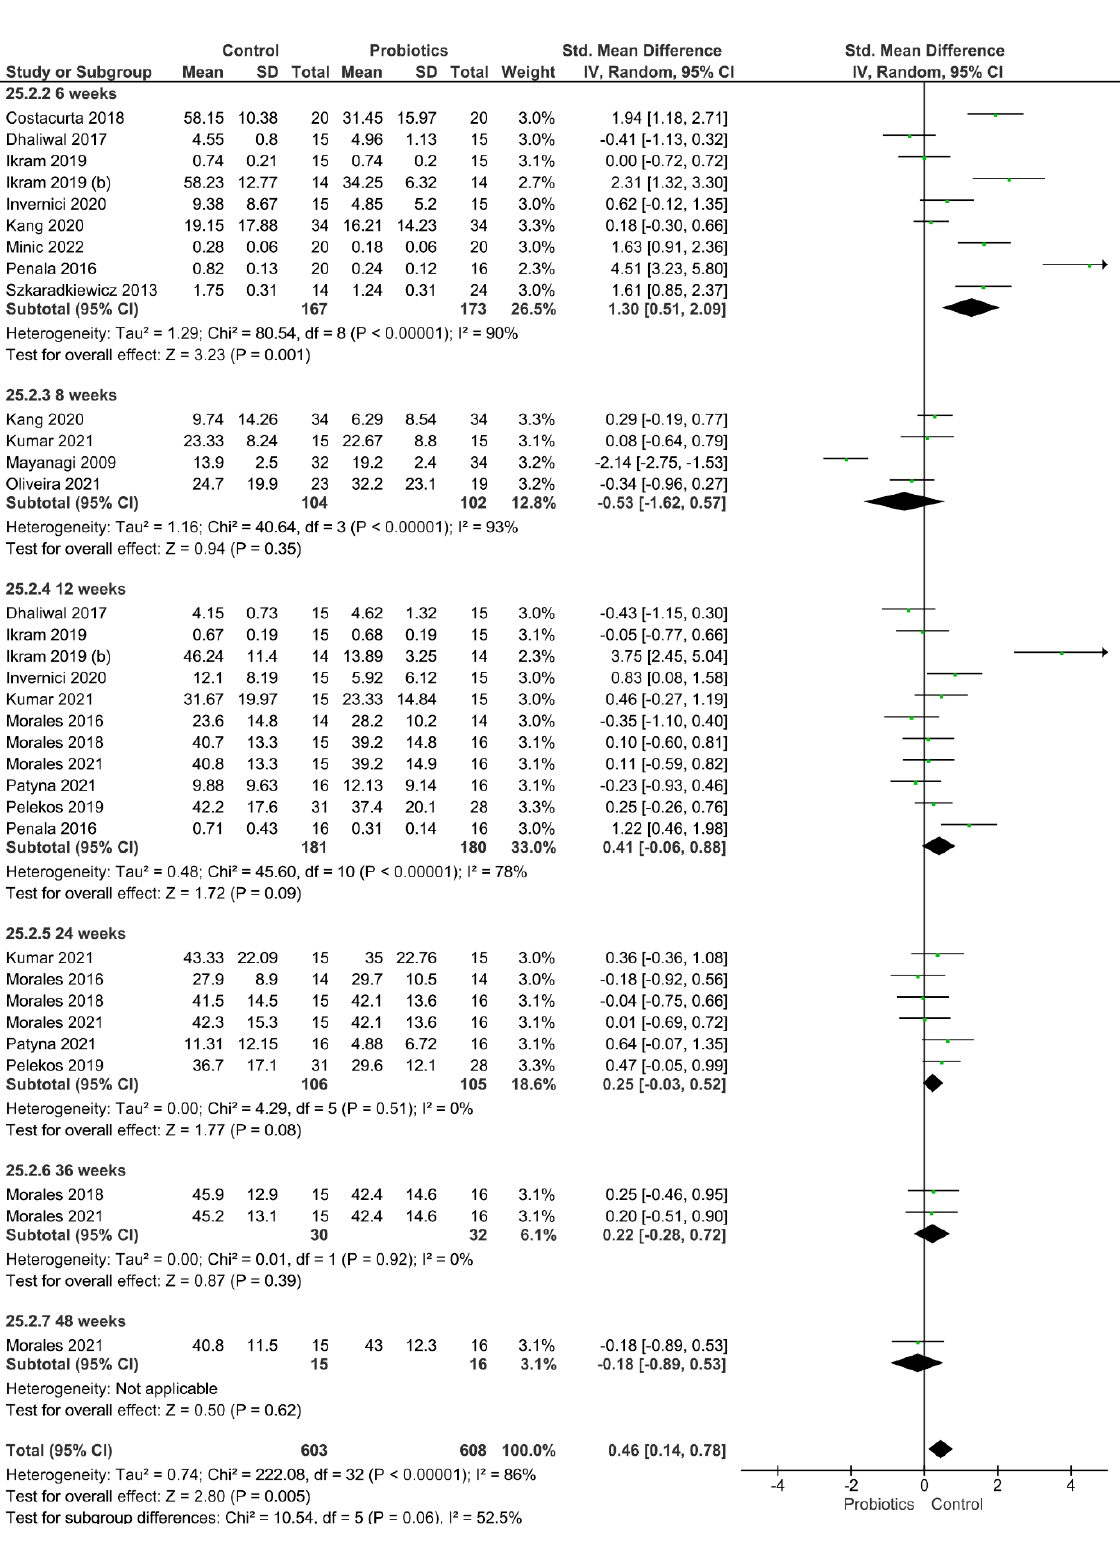
Figure 5. Results from the meta-analysis for the bleeding on probing parameter.